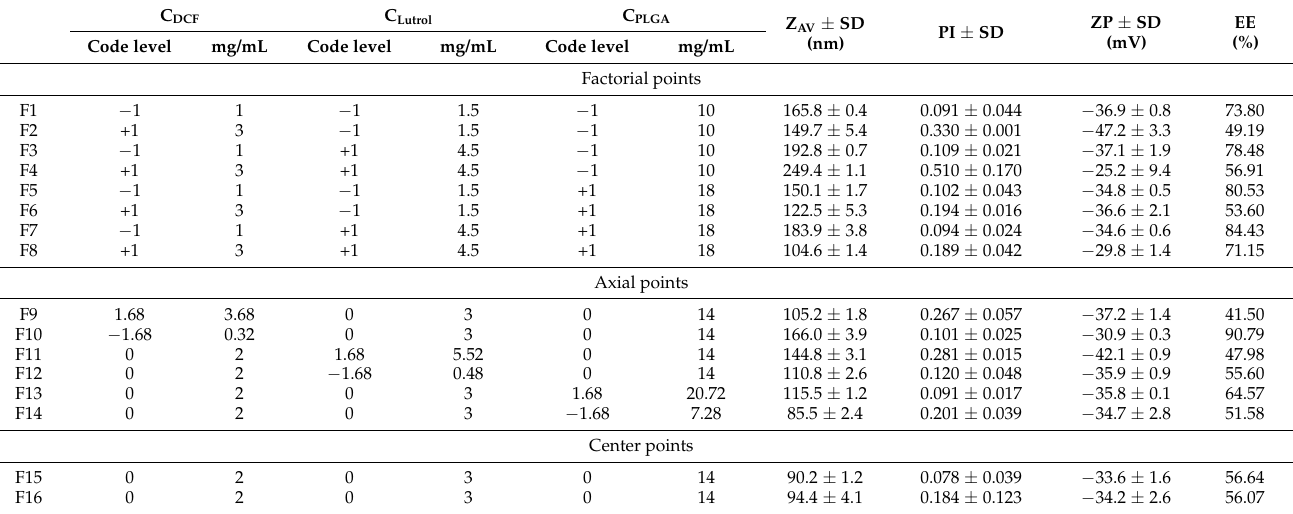
Table 1. DoE matrix, levels and physicochemical characterization of the